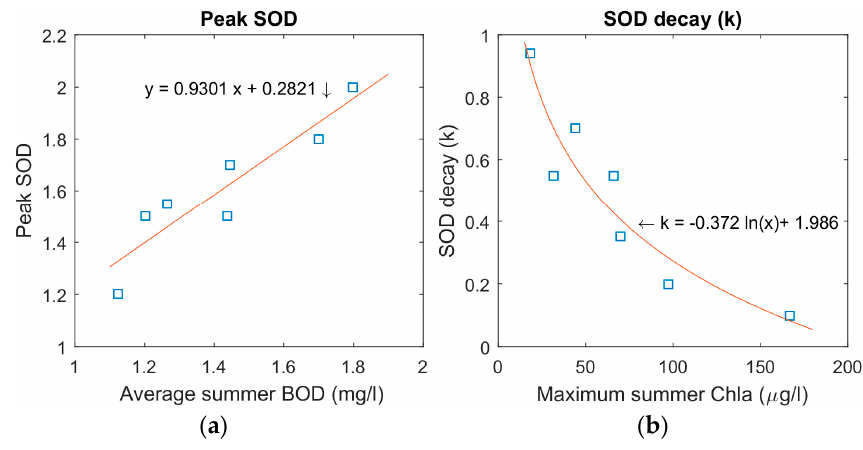
Figure 6. Relationships between SOD (day − 1 ), and observed BPL measurements, after the final DO model simulation: ( a ) Predicted peak SOD and average open water BOD inflows ( R 2 = 0.85); ( b ) Back-calculated winter SOD decay, and observed maximum summer Chla concentrations of the previous summer ( R 2 = 0.88).